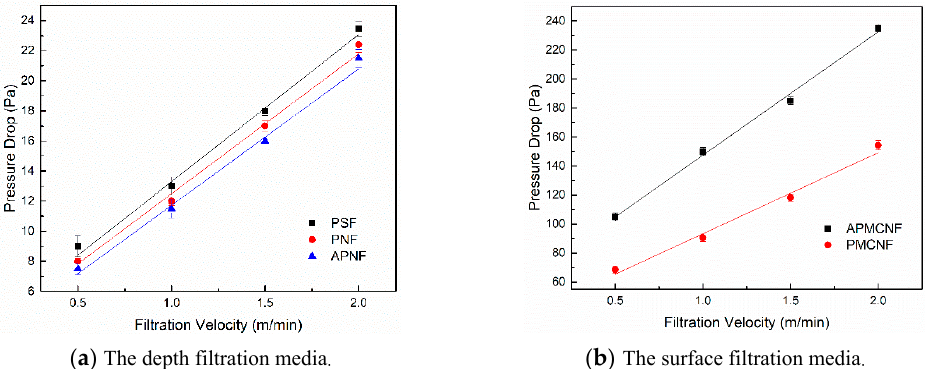
Figure 4. The pressure drop was plotted as a function of the filtration velocity of the clean filter